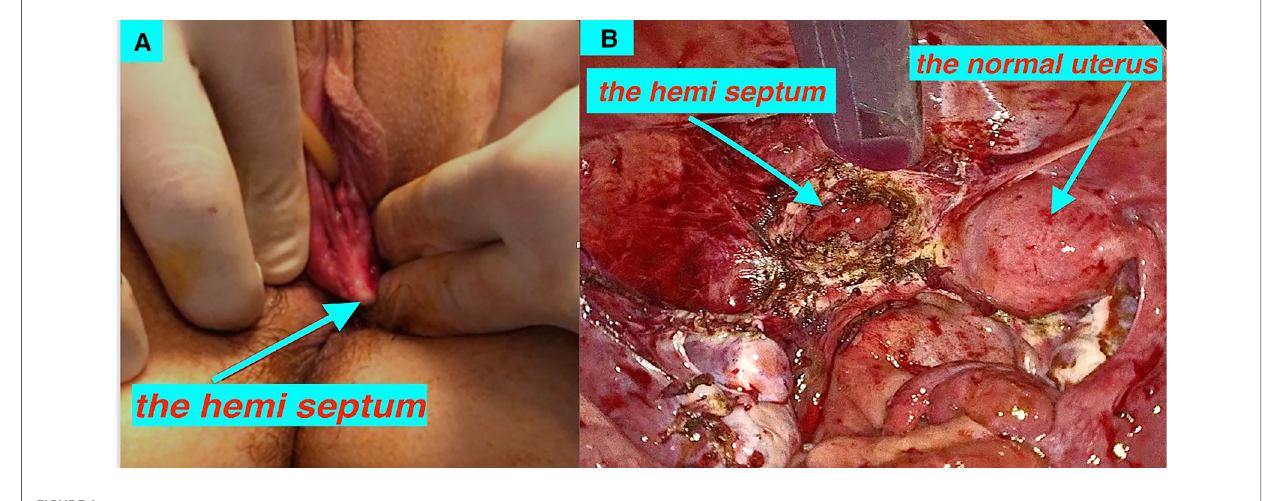
FIGURE 1 The laparoscopic grasper pushing downward the high